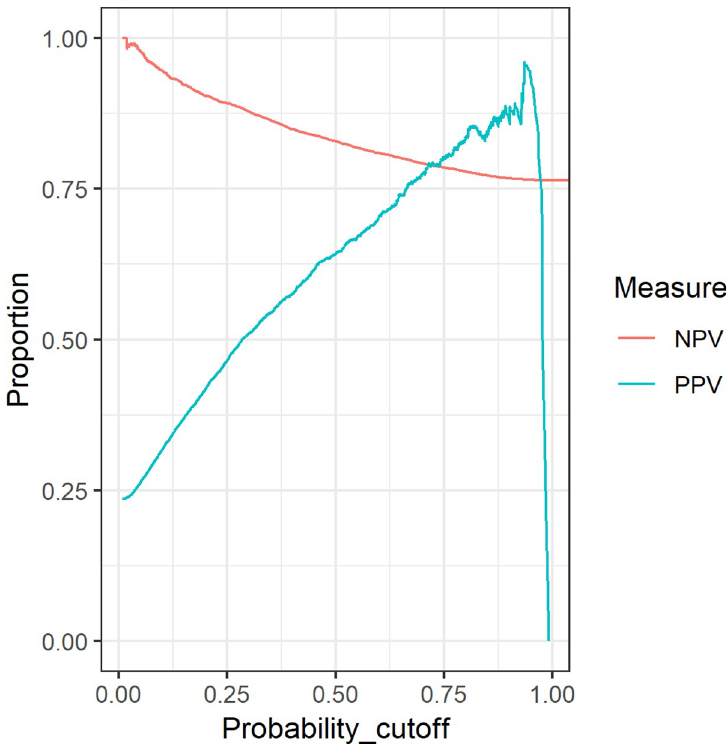
Fig 2. Positive and negative predictive value (PPV and NPV) for prediction of five-year mortality in the held-out test set across a range of probability cut-offs for the ICP model. https://doi.org/10.1371/journal.pone.0236011.g002 data set for iCOPD are compared in Table 4. Positive and negative predictive values for both models in the test set across a range of thresholds are given in Fig 2. Validation of models within the test set of UK practices Within the unlinked group, which was not used in model development, iCOPD performed well (area under the curve 0.794, calibration slope 0.978 and Brier 0.134). The performance of iCOPD was comparable between the linked and unlinked patient groups, this was also the case when the unlinked group was stratified by country (Table 5). from English practices. However, the performance of iCOPD in unlinked English practices was still acceptable (area under the curve 0.783, calibration slope 0.911 and Brier 0.133). Table 5. Comparison of iCOPD validation performance between the linked and unlinked groups, and regions of the UK. Region Brier score Calibration slope AUC England linked training set (80% of linked group) 0.139 1.00 0.797 England linked test set (20% of linked group) 0.139 0.991 0.801 All unlinked 0.134 0.978 0.794 England unlinked 0.133 0.911 0.783 Northern Ireland unlinked 0.120 1.00 0.809 Scotland unlinked 0.139 Wales unlinked